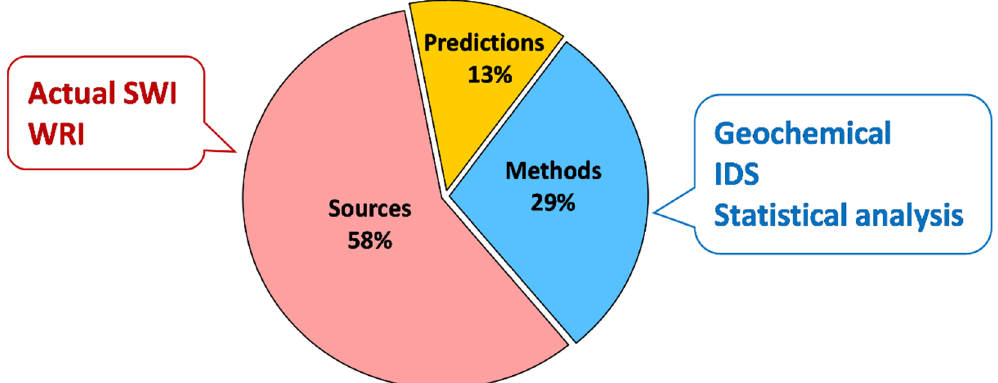
Figure 5. Main topics covered by the studies focusing on GW salinization along the Mediterranean coast. The most common methodologies applied in data acquisition and handling are reported in the blue call out while the most common sources of GW salinization are reported in the red call out.